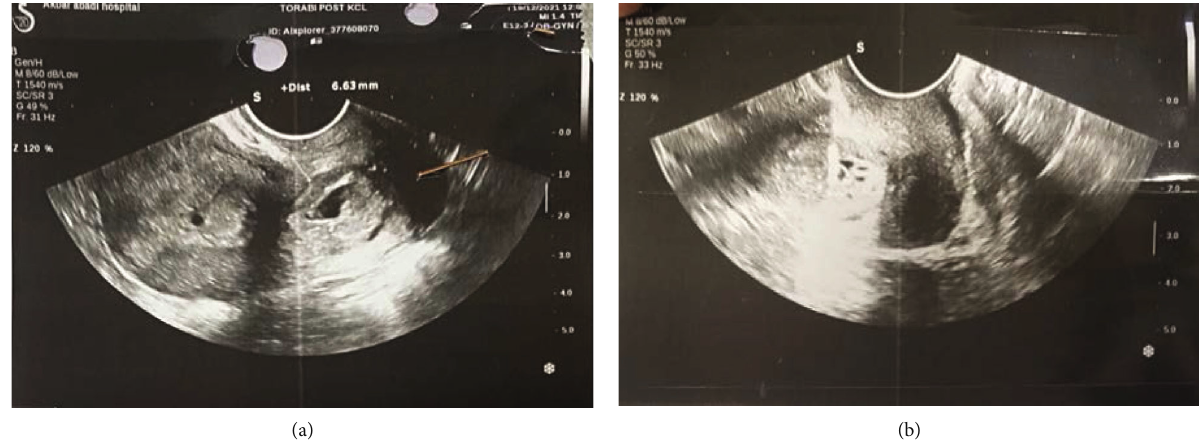
Figure 1: The obstetric ultrasonography shows the pregnancy sac and the yolk sac with the embryonic pole located near the internal os.